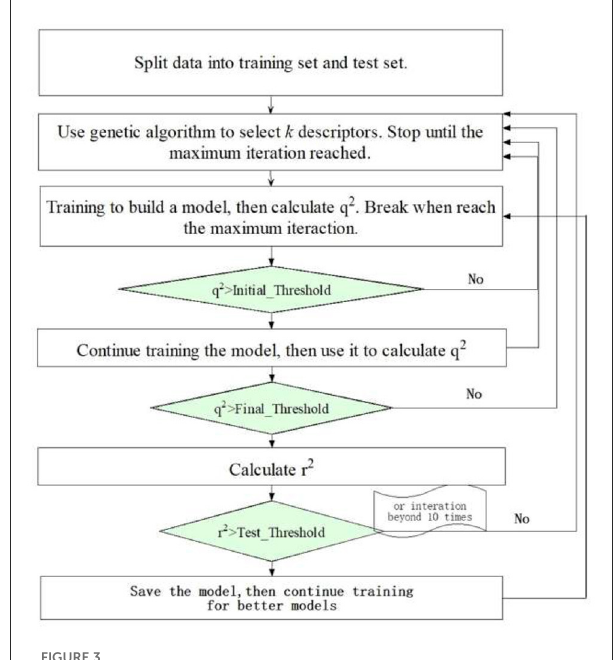
FIGURE3 The overall flowchart of JavaDL